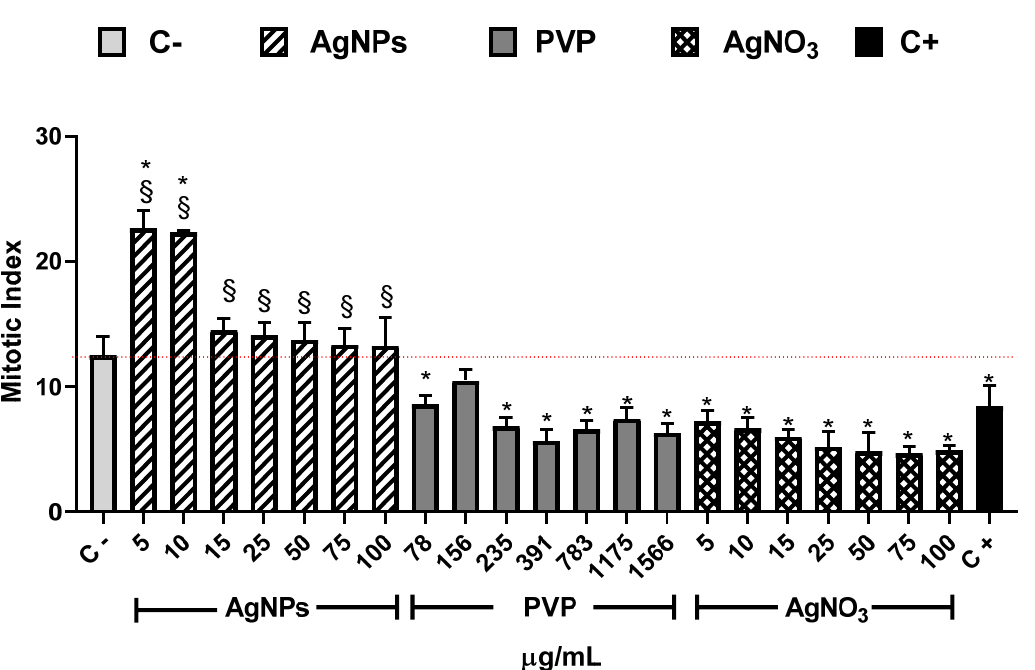
Figure 3. Mitotic index obtained after 72 h of exposure to the corresponding stimuli, AgNPs (lined), PVP (dark gray), and AgNO 3 (grid). The concentrations assessed are indicated in the figure. C − corresponds to untreated plants (light gray) and C + to those exposed to 0.37 µ g / mL of sodium arsenite (black). * Indicates significative di ff erences with the negative control ( p < 0.05); § indicates significative di ff erences with the positive control ( p <